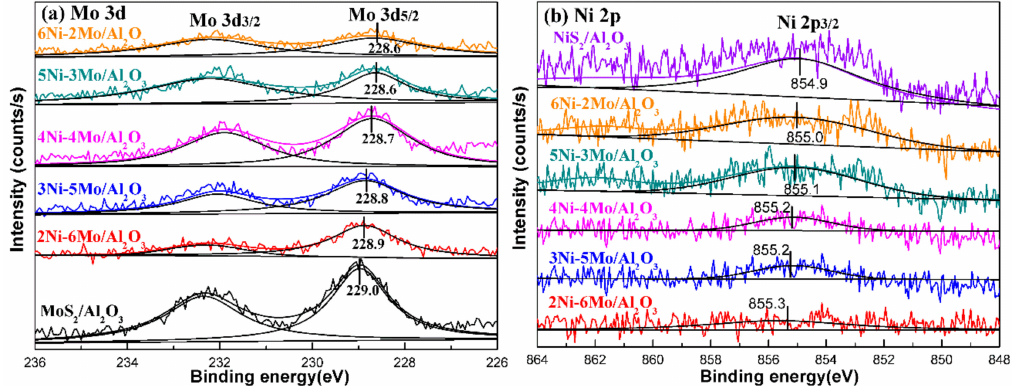
Figure 4. XPS spectra of the Ni-Mo sulfide / Al 2 O 3 catalysts with di ff erent Ni / Mo molar ratios: ( a ) Mo 3d, ( b ) Ni